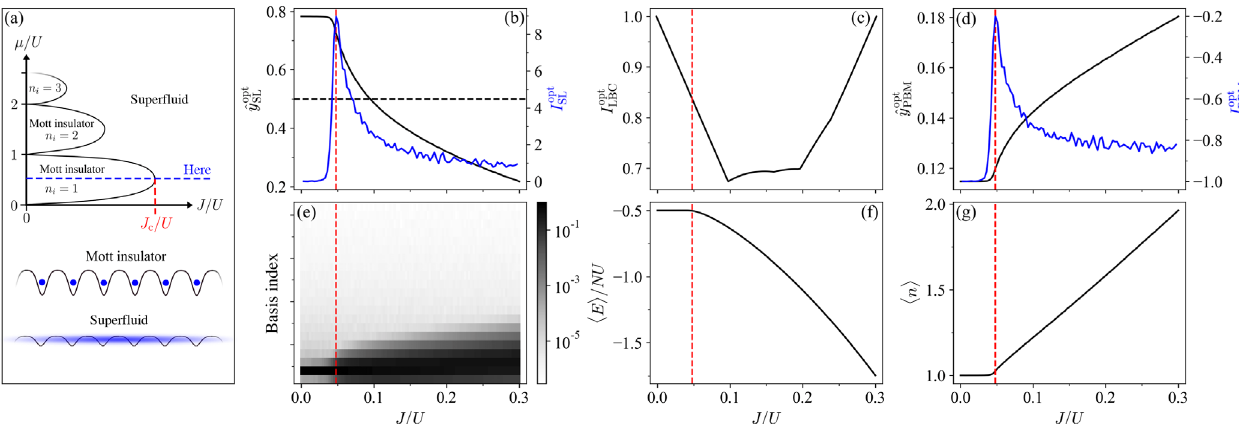
FIG. 18. Results for the Mott insulating to superfluid phase transition in the (two-dimensional) Bose-Hubbard model with the 0 . 3 in steps of Δ p ¼ 0 . 03 , where dimensionless coupling strength as a tuning parameter p ¼ J=U ranging from p 1 ¼ 0 to p K ¼ μ =U ¼ 0 . 5 . In SL, the data obtained at p 1 and l K . The reference value for the critical 1 and p K constitute our training set, i.e., r I ¼ II ¼ =U ¼ 1 = ð 5 . 8 z Þ with z ¼ 4 [147] is highlighted by a red dashed line. (a) Illustration of the two- value of the tuning parameter J c dimensional phase diagram of the Bose-Hubbard model containing three Mott lobes. Here, we analyze the quantum phase transition from a Mott insulating state to a superfluid state occurring at the tip of the first Mott lobe ( μ =U ¼ 0 . 5 ). A sketch of the two distinct phases is shown on the bottom. (b) Mean optimal prediction ˆ y opt in SL (black solid line) and the corresponding indicator I opt (blue line). SL SL The value ˆ y opt (black line). (d) Mean optimal prediction ¼ 0 . 5 is highlighted by a black dashed line. (c) Optimal indicator of LBC, I opt SL LBC ˆ y opt in PBM (black line) and the corresponding indicator I opt (blue line). (e) Probability distributions governing the input data (indices PBM PBM n max ) as a function of the tuning parameter, where the color scale denotes the probability. (f) Average energy per of Fock basis states fj n i ig i ¼ 1 site ( N ¼ L sites in total) as a function of the tuning parameter. Notice the drop in the average energy as the system undergoes the quantum phase transition. (g) Average occupation number per site h n i as a function of the tuning parameter.